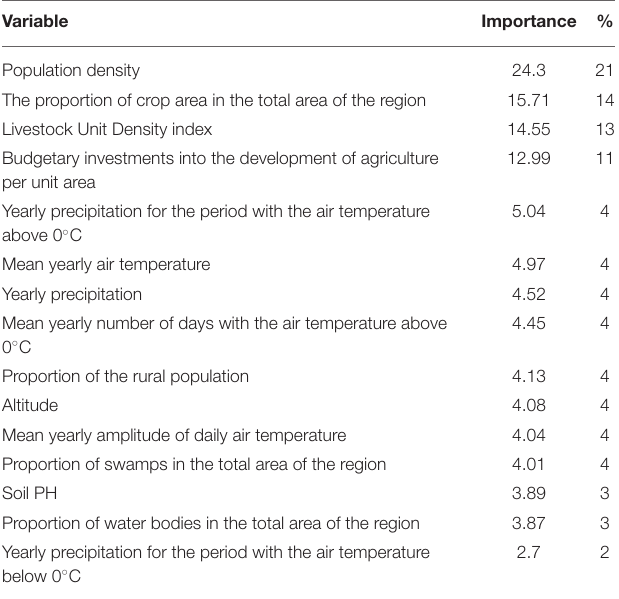
TABLE 1 | Relative importance of variables based on random forest-based classification and regression analysis